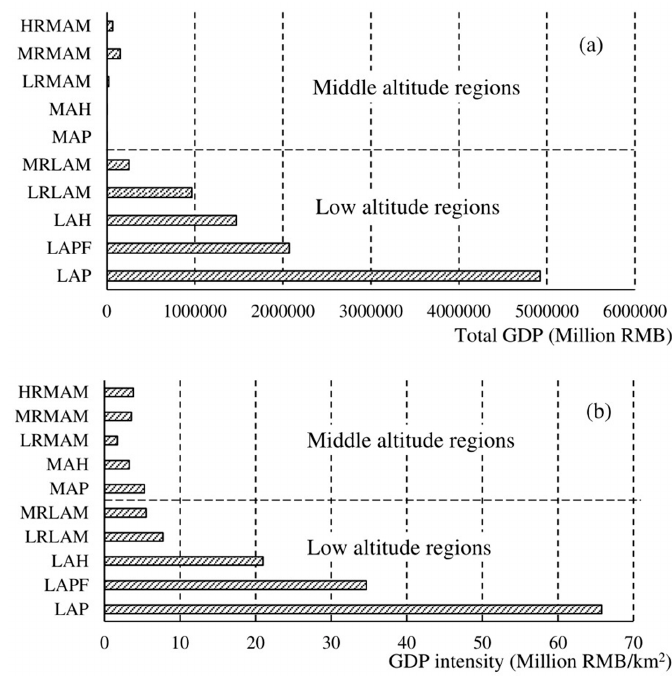
Figure 10. ( a ) Total GDP; and ( b ) GDP intensity of basic geomorphological types of South China in 2014.